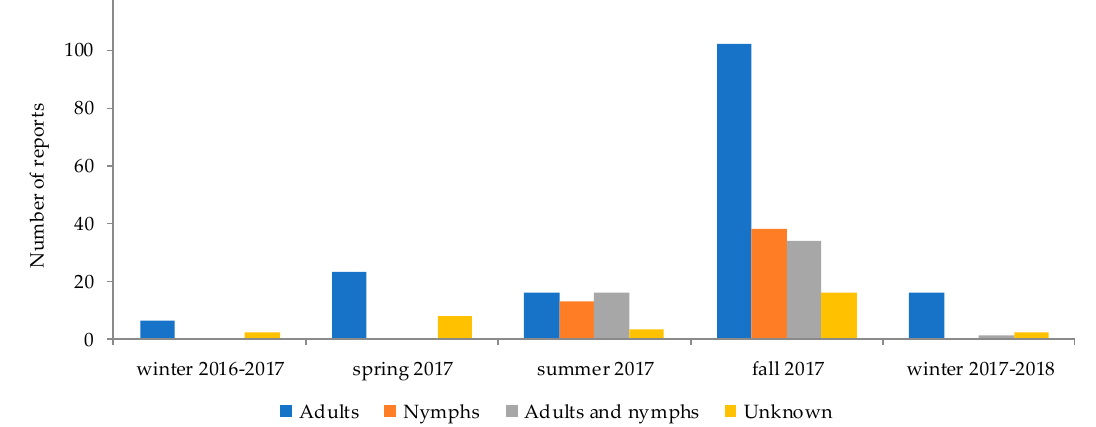
Figure 5. The number of sightings of different BMSB life stages is showcased with respect to the date of the report. Life stages are classified according to the original reports; “unknowns” are specimens that users were unable to classify.